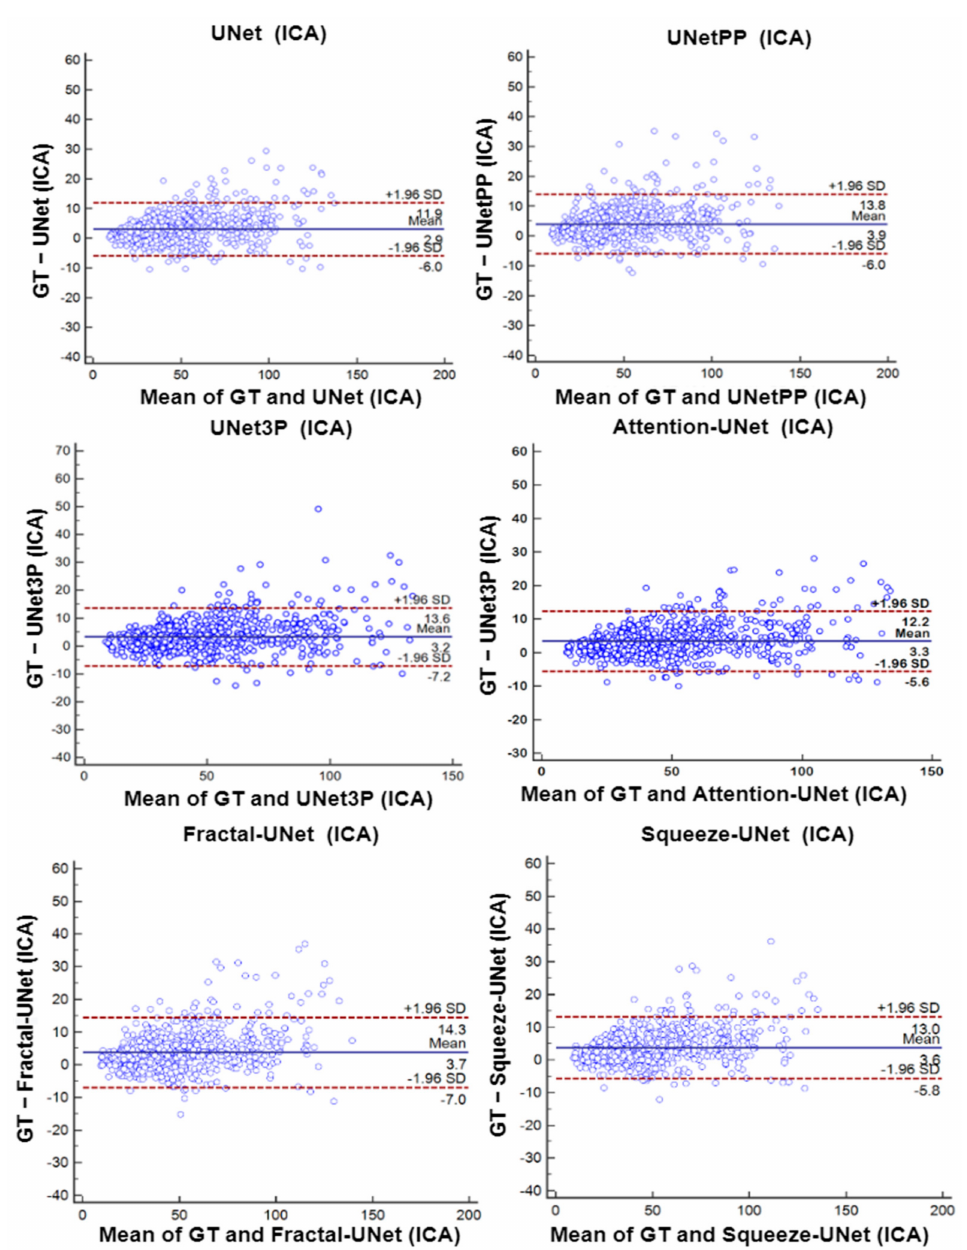
Figure 16. Bland–Altman Plot of all 6 types of models for ICA DB1